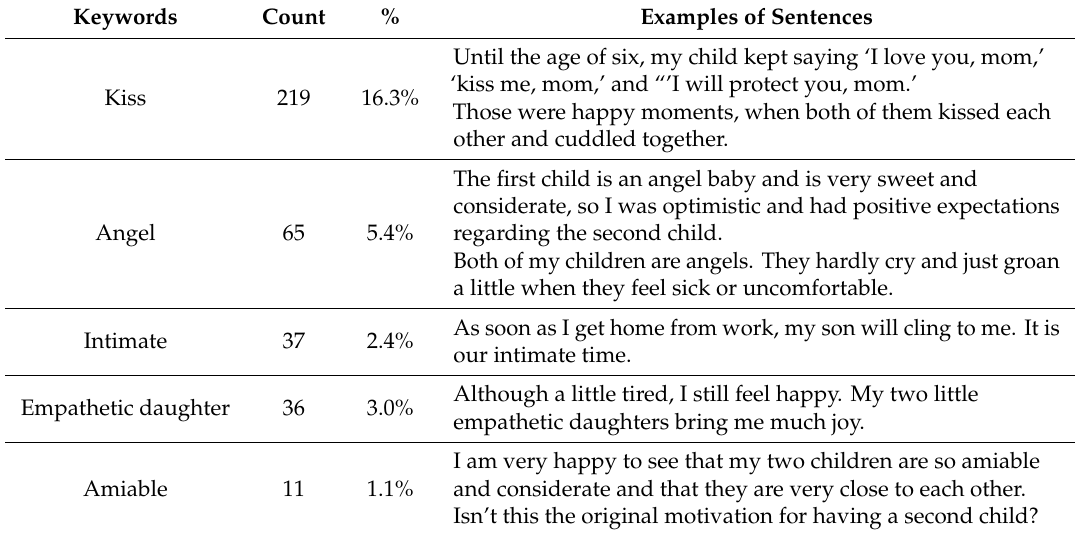
Table 4. Keywords indicating mental benefits and sentence